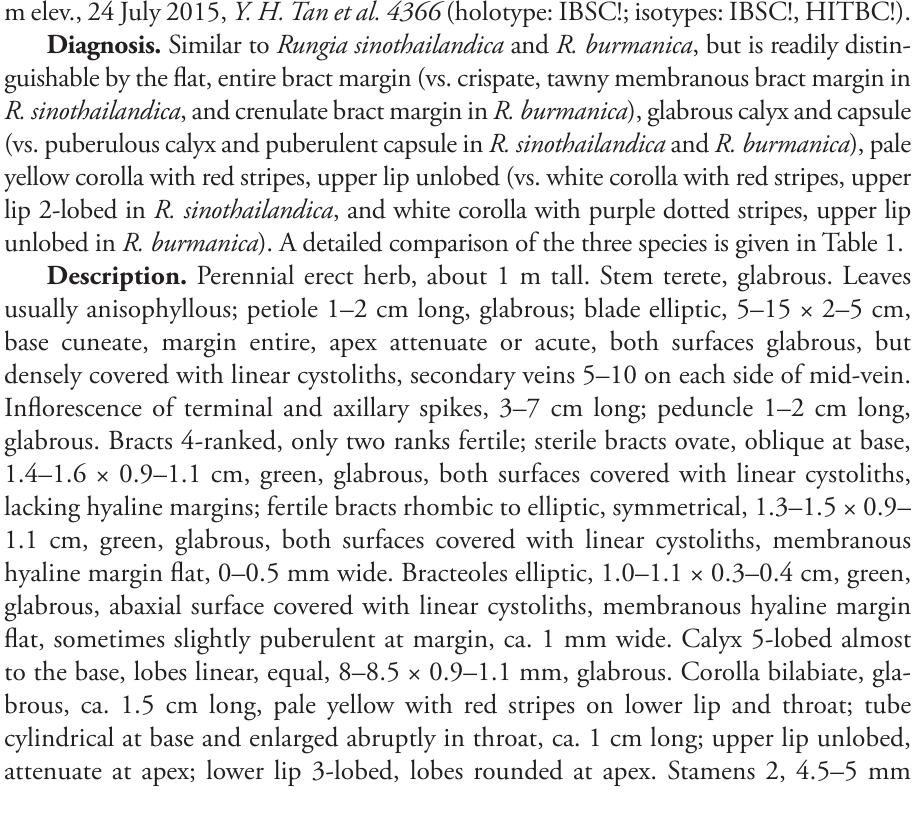
Table 1. Morphological comparison of Rungia fangdingiana , R. sinothailandica and R. burmanica .